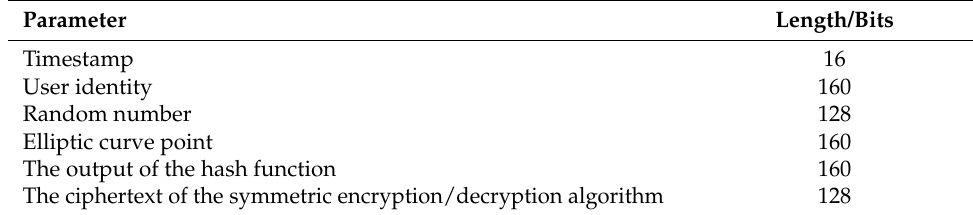
Table 8. Lengths of the safety parameters.